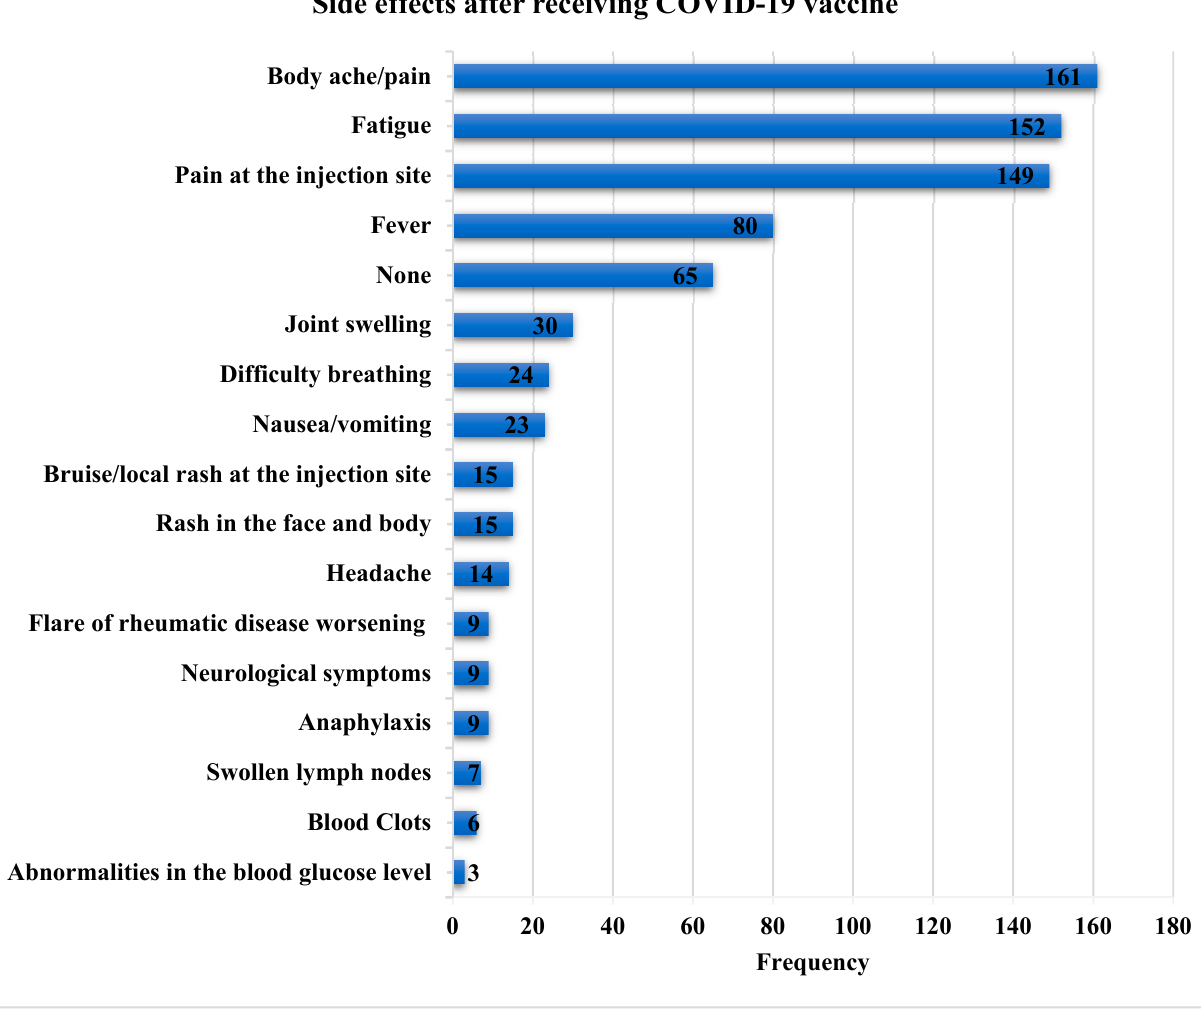
Table 3. Flares post-vaccination (n =